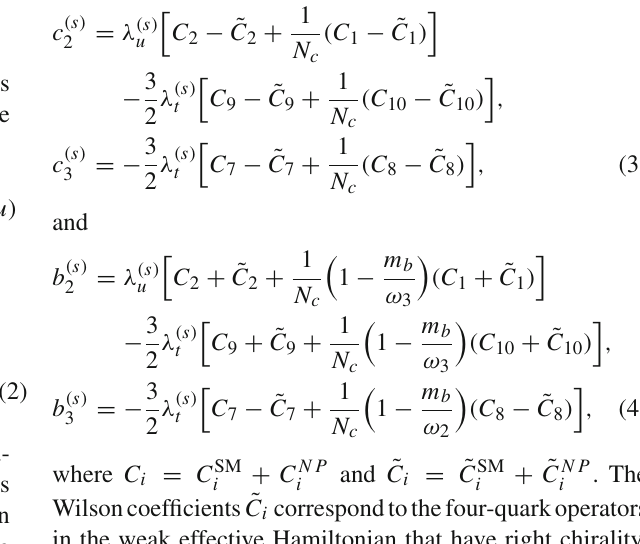
Table 1 Hard kernels of ¯ B 0 s → η s , q π 0 (ρ 0 ) decays. The hard kernels T iJ , T iJg ,for i = 1 , 2,canbeobtainedthroughthereplacement c s Decay